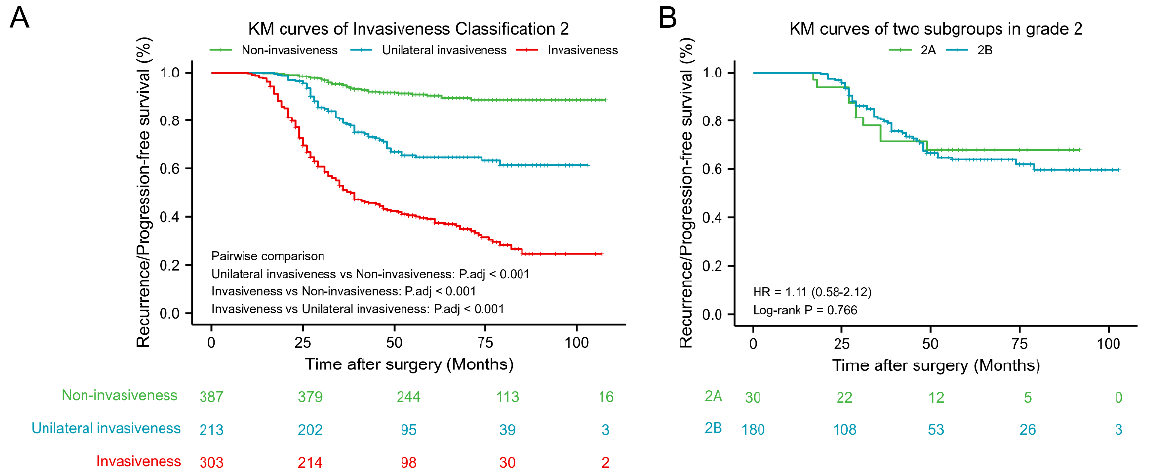
Figure 7. Kaplan–Meier survival analysis of Invasion Classification 2. ( A ) Kaplan–Meier survival curves of Invasion Classification 2. ( B ) Kaplan–Meier survival curves of two subgroups in grade 2. Non-invasiveness: Invasion Classification grade 0–1; Unilateral invasiveness: Invasion Classification grade 2; Invasiveness: Invasion Classification grade 3–4; 2A: Knosp grade 3 PAs without surgical invasiveness; 2B: Knosp grade 0–2 PAs with surgical invasiveness. KM: Kaplan–Meier; HR, Hazard Ratio.